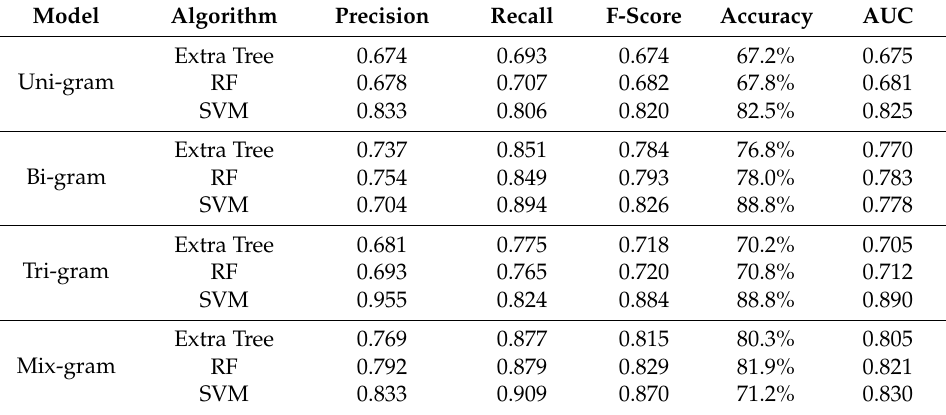
Table 16. Summary of classification algorithms with n-gram model on test